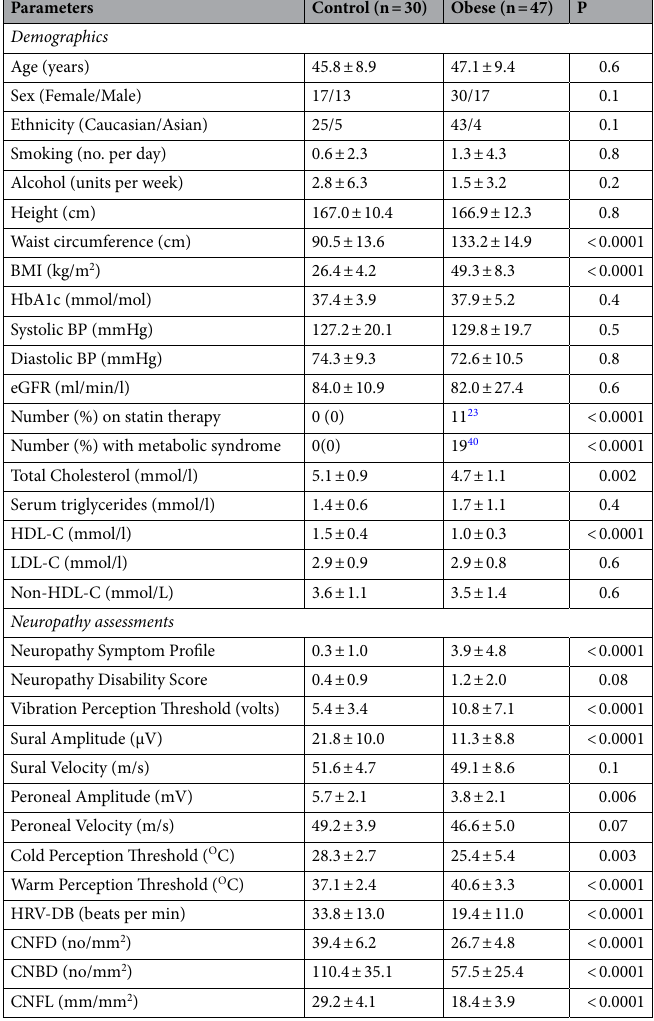
Table 1. Clinical, metabolic and neuropathy measures in controls and participants with obesity. Results reported as mean ± standard deviation; BMI (body mass index); BP ( blood pressure); eGFR (estimated glomerular filtration rate); HDL-C (high density lipoprotein cholesterol); LDL-C (low density lipoprotein cholesterol); HRV-DB (Heart rate variability-deep breathing; CNFD (corneal nerve fibre density); CNBD (corneal nerve branch density); CNFL (corneal nerve fibre